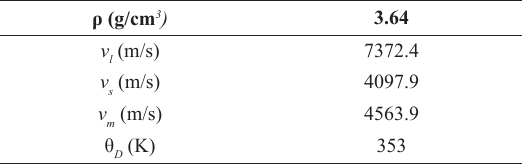
Table 2. Right numerical values of the density, the longitudinal ( v ), transverse ( v l temperature of Cu